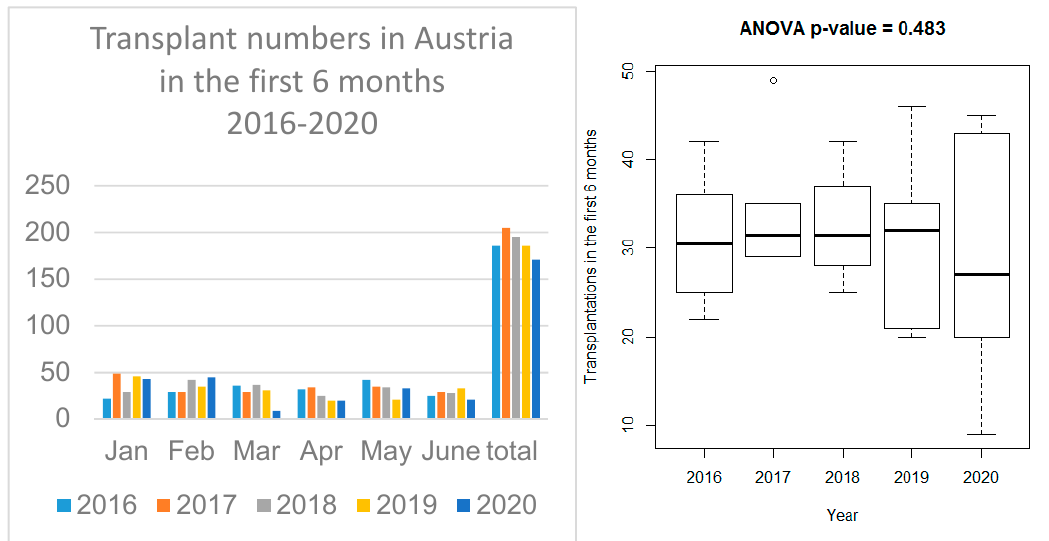
Figure 1. Monthly number of kidney transplants in Austria during the COVID-19 pandemic (January to June 2020) and comparison of the monthly average in previous years by ANOVA (data from the four Austrian transplant centers in Vienna, Innsbruck, Graz and Linz).